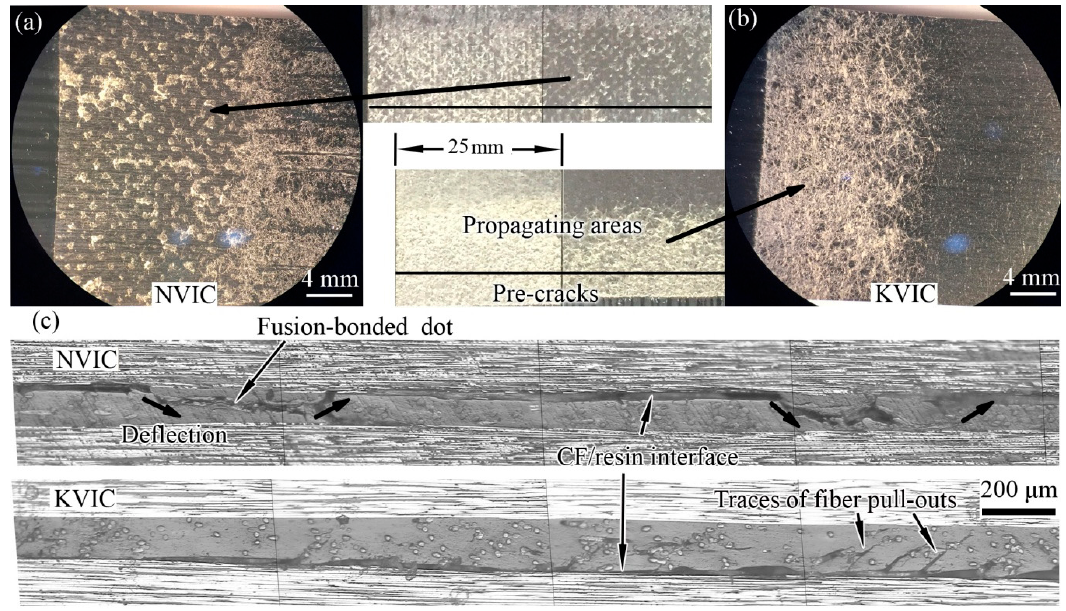
Figure 6. Optical micrographs and images of the Mode II fracture surfaces of the ( a ) NVIC and ( b ) KVIC, and ( c ) cross sectional metallographic micrographs of the Mode I fractured NVIC and KVIC samples.